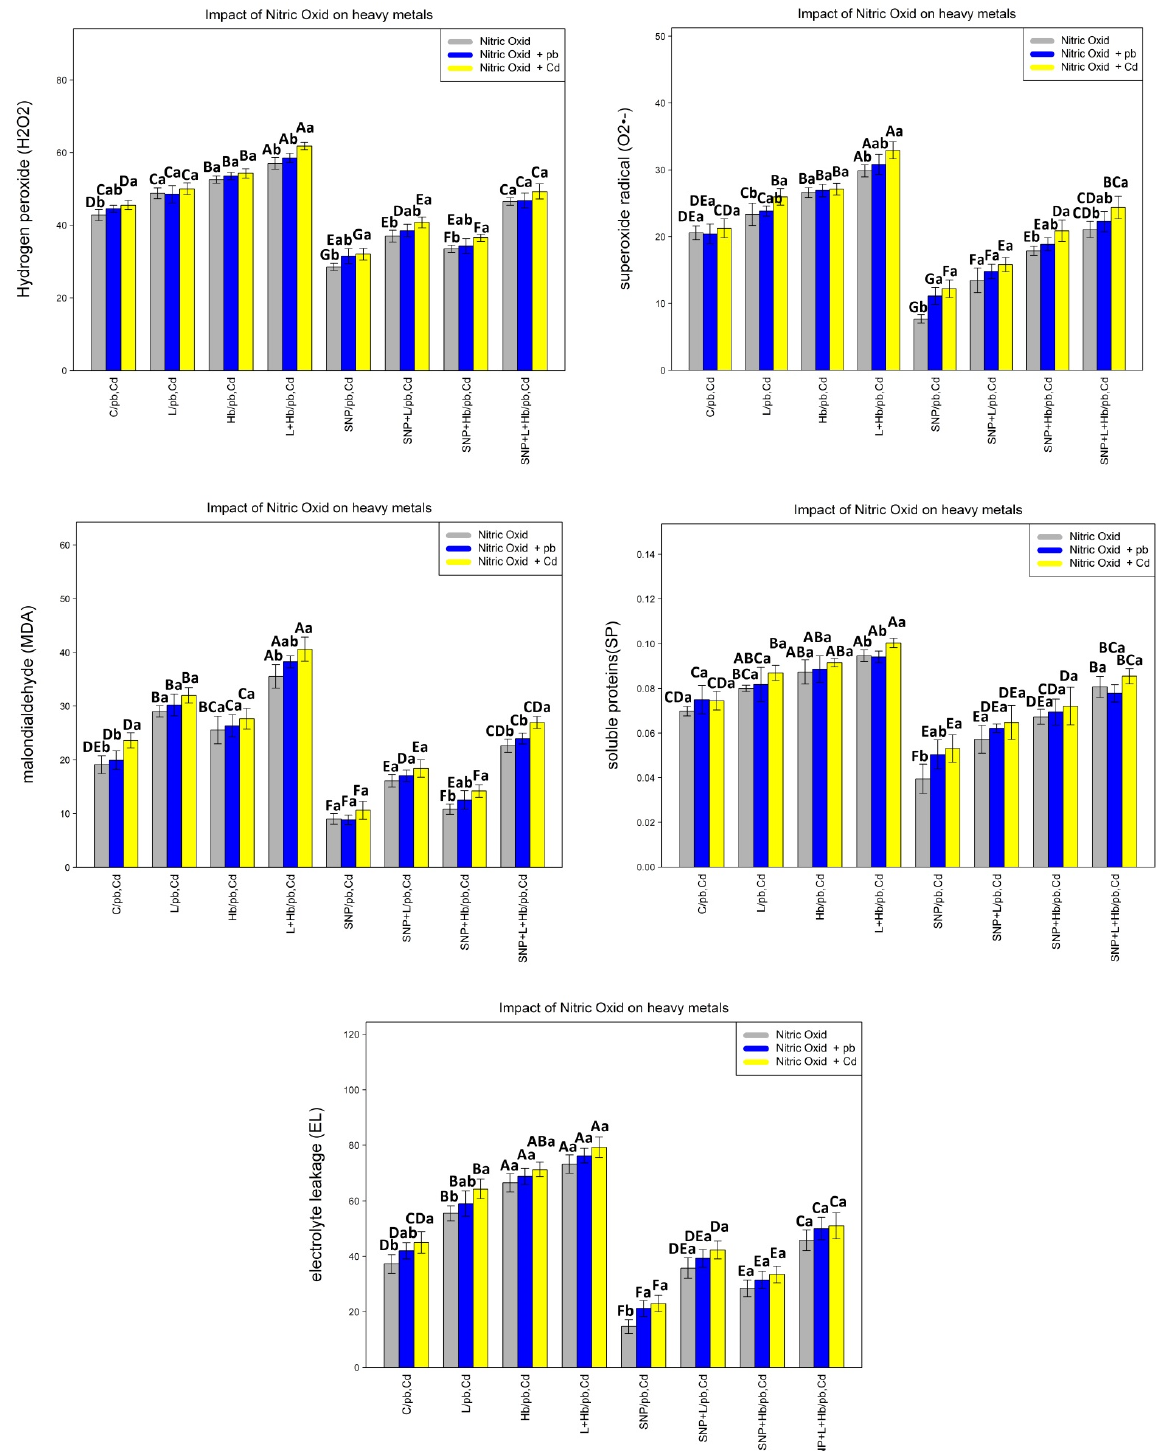
Figure 2. Effect of nitric oxide (NO) concentrations on hydrogen peroxide (H 2 O 2 ), superoxide radical (O2 •− ), soluble proteins (SP), lipid peroxidation (MDA), and electrolyte leakage (EL) of A. pygmaea L. with 200 µ M Pb and 200 µ M Cd. The treatments contained various concentrations of nitric oxide alone or in combination with 200 µ M Pb and 200 µ M Cd. The capital letters showed statistically significant differences across various levels of nitric oxide alone or in combination with 200 µ M Pb and 200 µ M Cd (the bars with the same colors), while the lowercase letters showed statistically significant differences within each concentration of nitric oxide (NO) alone or in combination with 200 µ M Pb and 200 µ M Cd (the bars with different colors) according to Tukey’s test ( p <